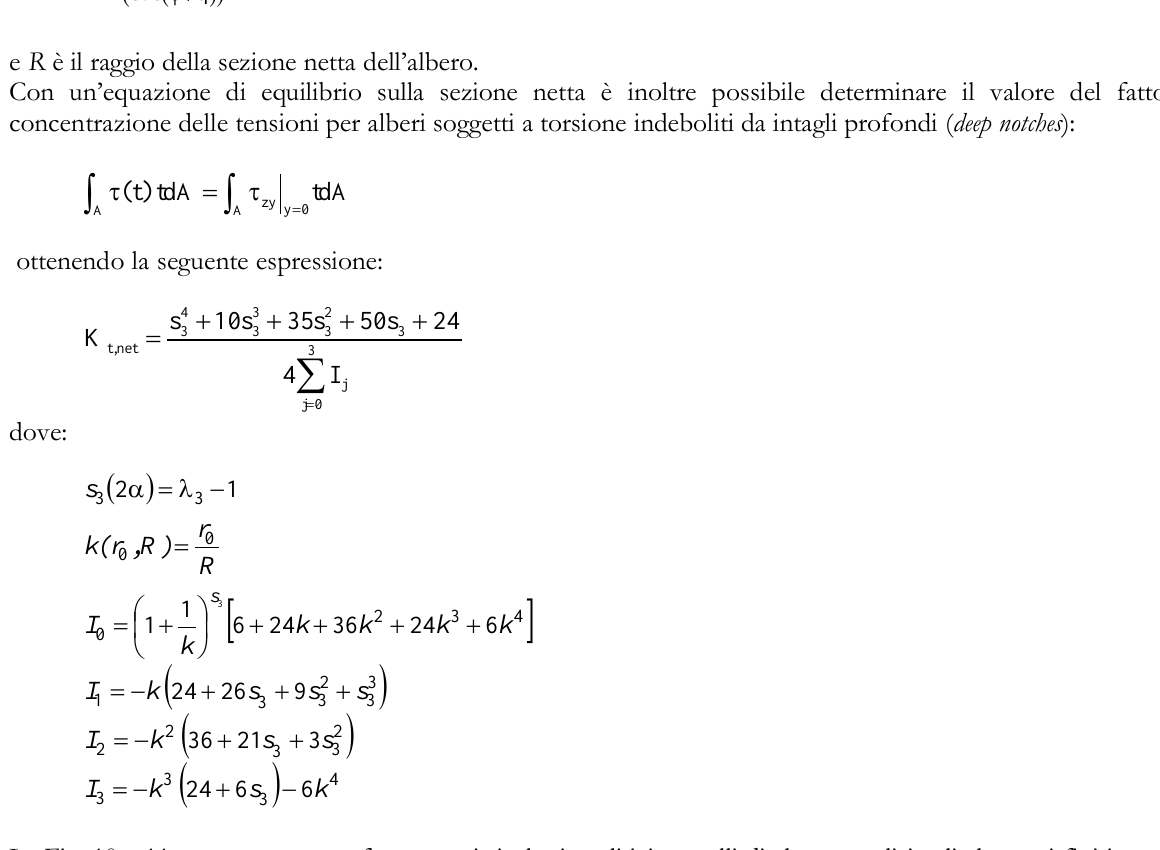
Le Fig. 10 e 11 mostrano un confronto tra i risultati analitici e quelli di alcune analisi agli elementi finiti condotte su alberi indeboliti da intagli di varia forma e soggetti a torsione; l’accordo appare molto